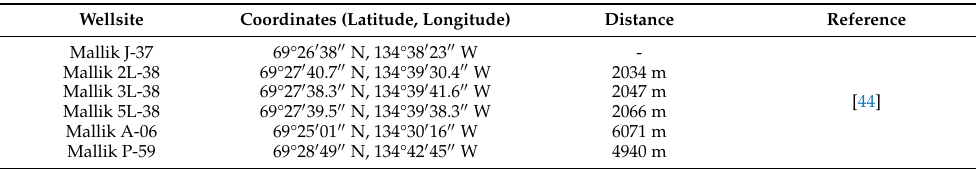
Table A1. Coordinates of the Mallik wells and their distances to the Mallik J-37 well serving as the projection origin. Wellsite Coordinates (Latitude, Longitude) Distance